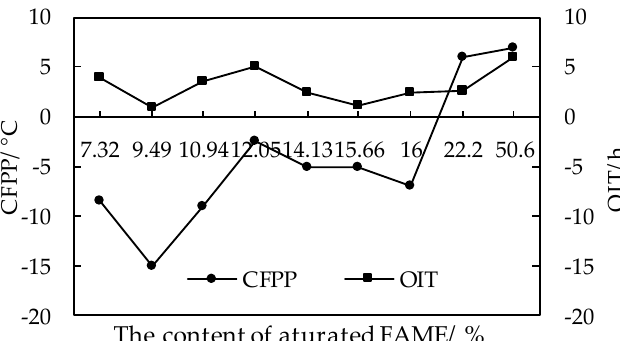
Figure 8. Effects of saturated FAME (fatty acid methyl ester) on low temperature fluidity and oxidation stability of biodiesel.